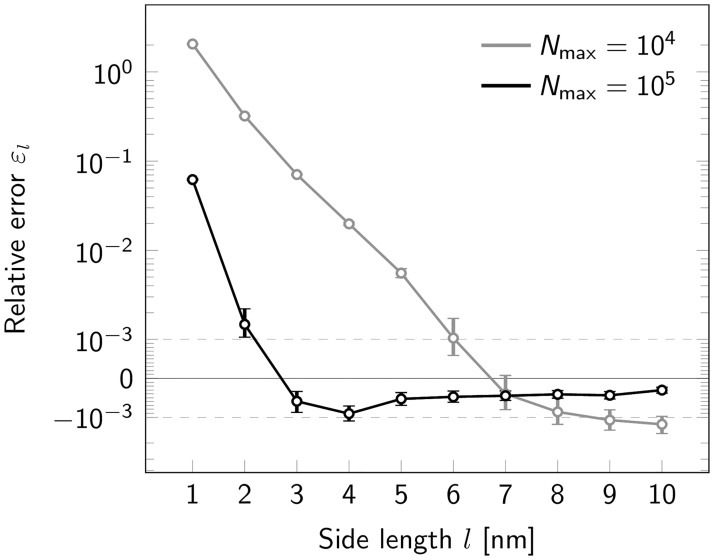
Influence of oligomer side length.Relative error εl for estimation of tetramer side length upon variation of the nominal side length l shown in a symmetric logarithmic plot. Results are shown both for a maximum photon number Nmax = 104 (gray) and Nmax = 105 (black). Positive and negative relative errors represent overestimation and underestimation, respectively. For each data point a data set of 500000 tetramers was simulated. Error bars indicate the 95% confidence intervals.